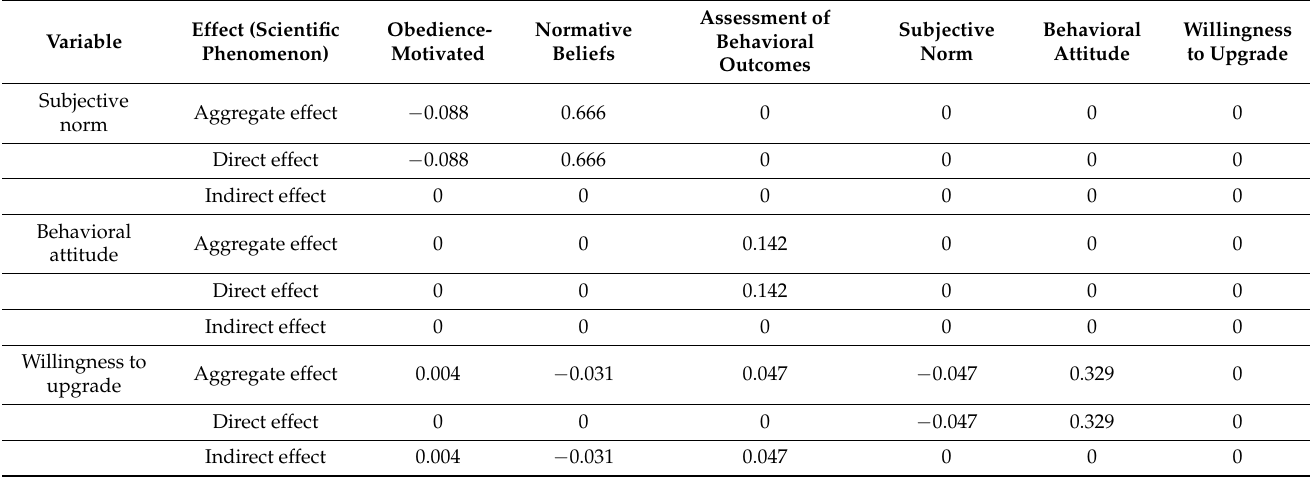
Table 6. Results of direct effects, indirect effects, and standardization of total effects among the potential variables in the